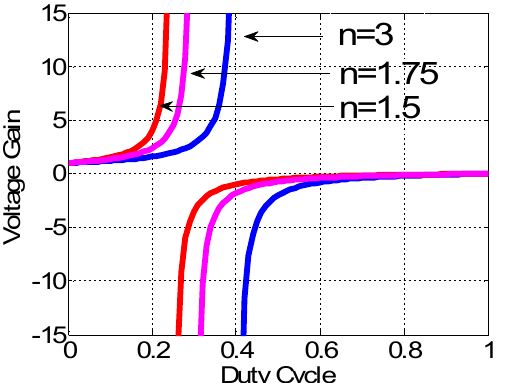
Figure 8. Output voltage gain versus duty cycle with different turns ratio.